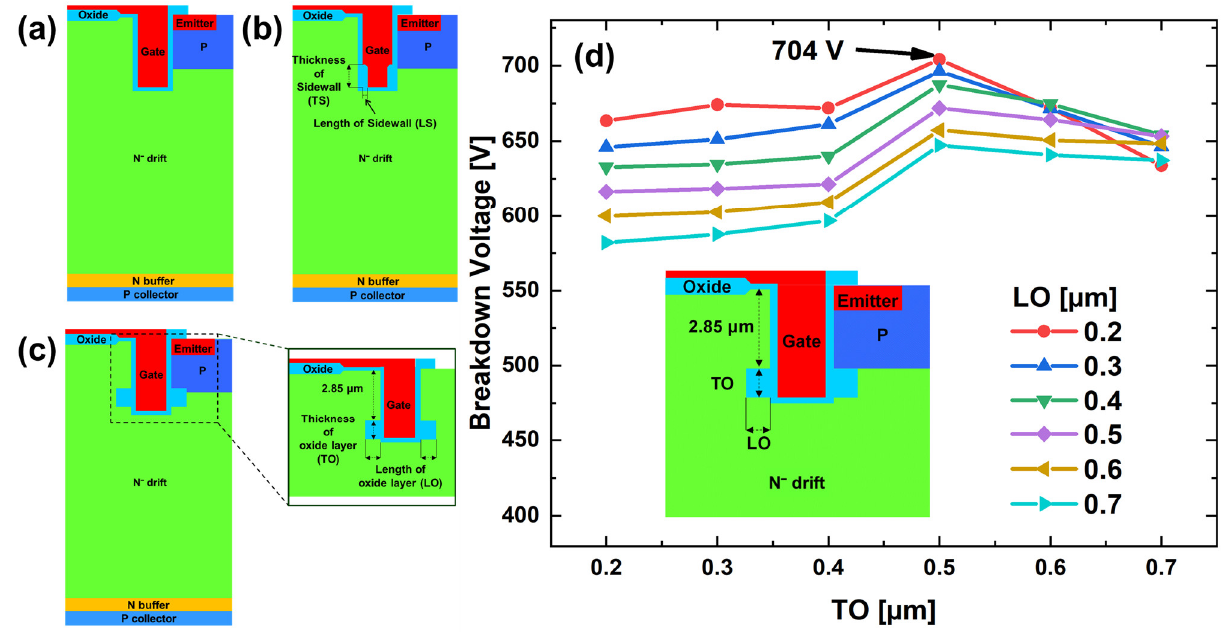
Figure 1. The structures of ( a ) C-IGBT, ( b ) S-IGBT and ( c ) O-IGBT. ( d ) breakdown voltage according to the oxide layer parameters in O-IGBT.